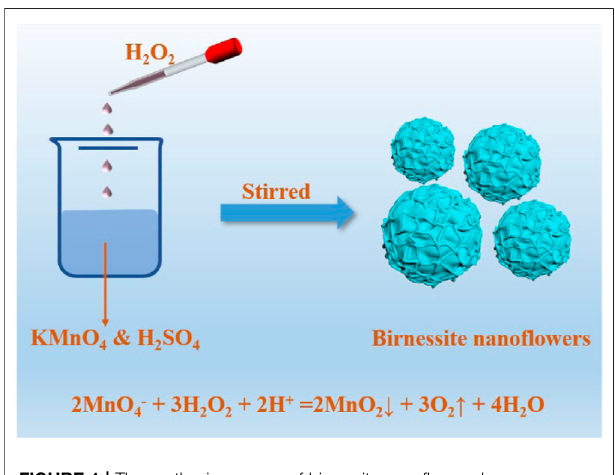
FIGURE 1 | The synthesis process of birnessite nano fl owers by adjusting the ratio of KMnO 4 to H 2 O 2